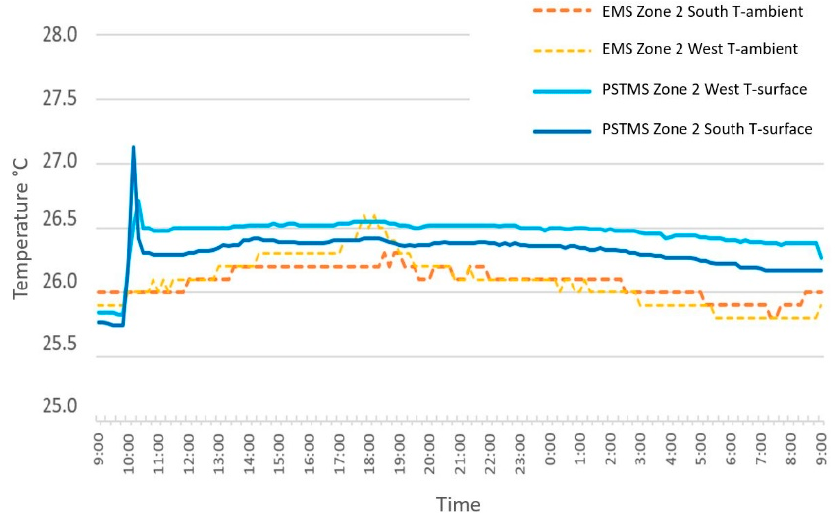
Figure 8. Air and surface temperature in Zone 1 for north orientation on 16 September 2019.